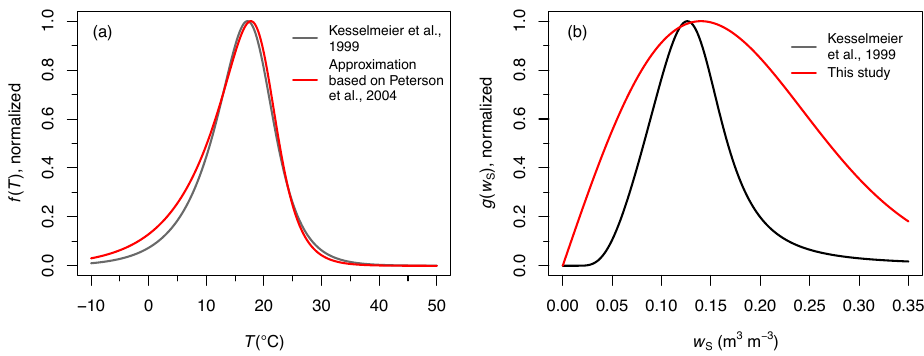
Figure 3. (a) Temperature dependence function of soil COS uptake (Eq. 22) with (cid:49)H eq = 358 . 9kJmol − 1 and T eq = 20 ◦ C. (b) Moisture dependence function of soil COS uptake (Eq. 23) with w opt = 0 . 14m 3 m − 3 . Also plotted are the temperature and moisture dependence functions of Kesselmeier et al. (1999). Table 1. COS solubility functions in the literature and in this study. Reference Model